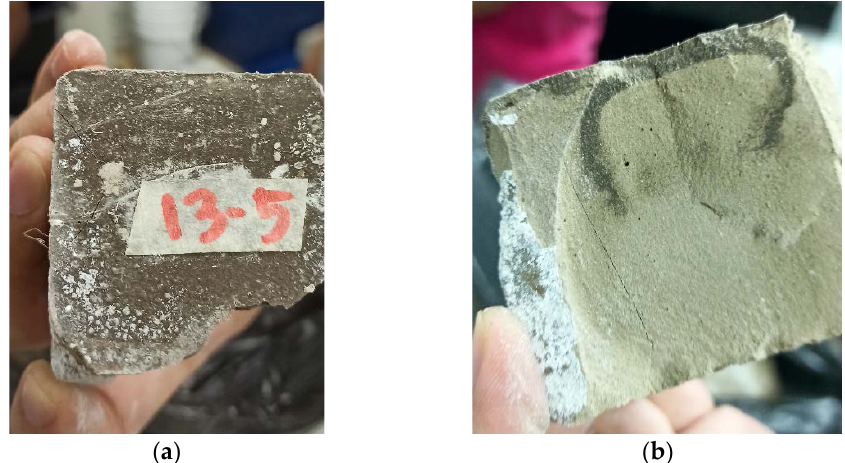
Figure 6. Evidence of subflorescence on sample 5 of mix 13. ( a ) Top View of the sample (post-test) ( b ) Plane of failure of the sample after compressive test, showing existing crystal deposit within the matrix.